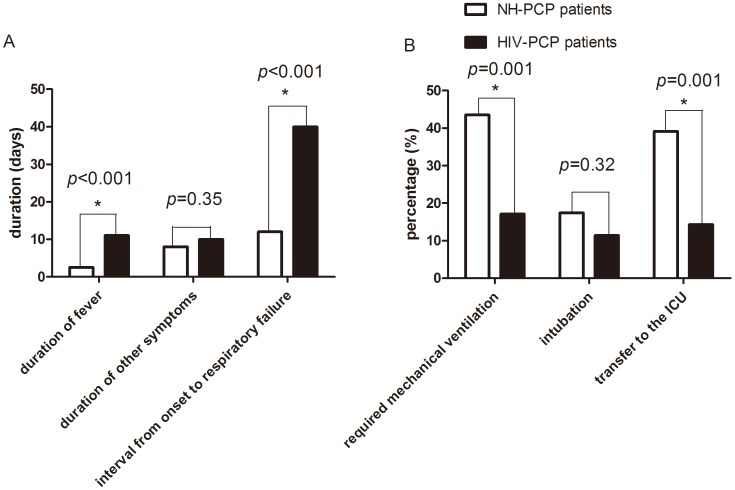
Clinical course.Clinical presentations of the NH-PCP and HIV-PCP patients (A). Secondary endpoints of the two groups (B). The results are reported as median and rate, The comparisons were determined by χ2 tests or Wilcoxon rank-sum test. *P<0.05 compared with the corresponding controls.